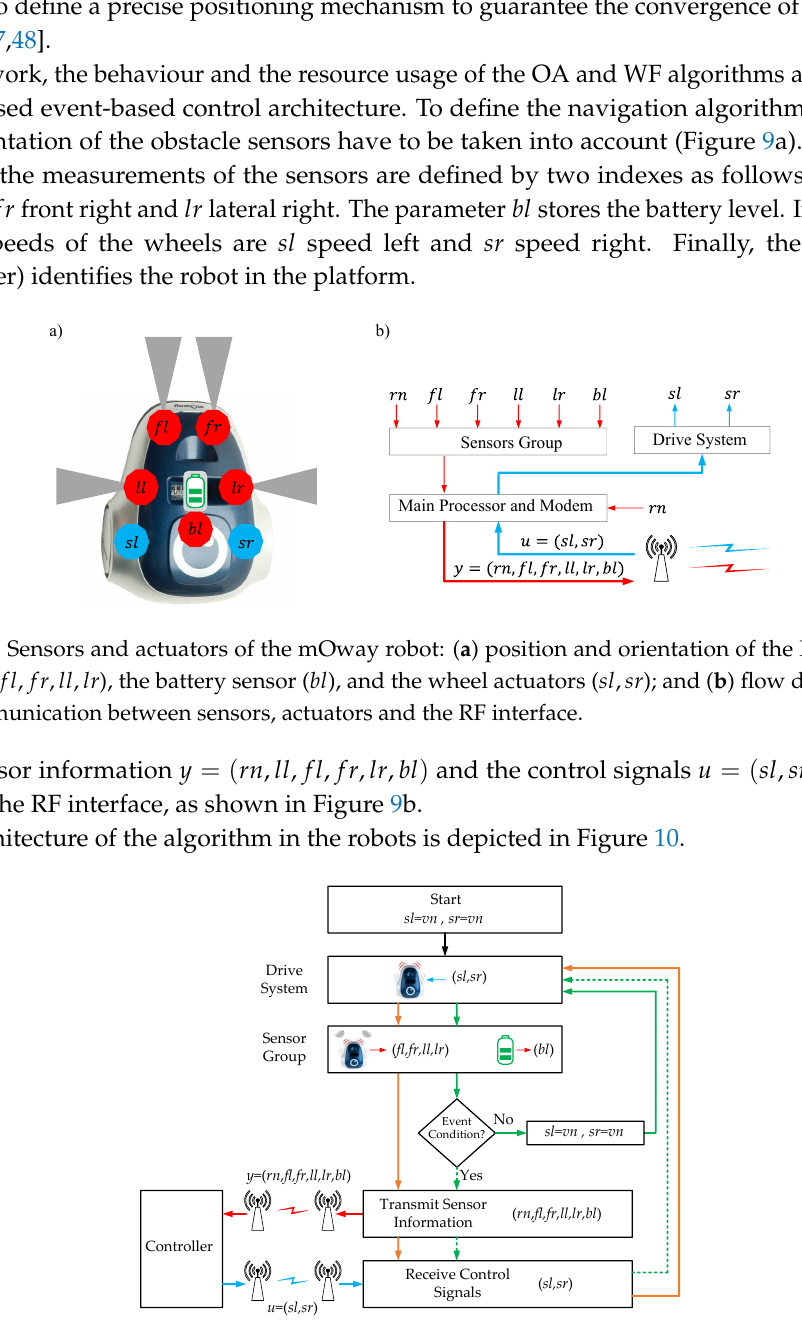
Figure 10. Robot control algorithm. The orange arrows represent the discrete-time solution and the green arrows the event-based implementation. The blocks with continuous arrows are executed each period of time T and the blocks with dotted arrows when an event is generated in the